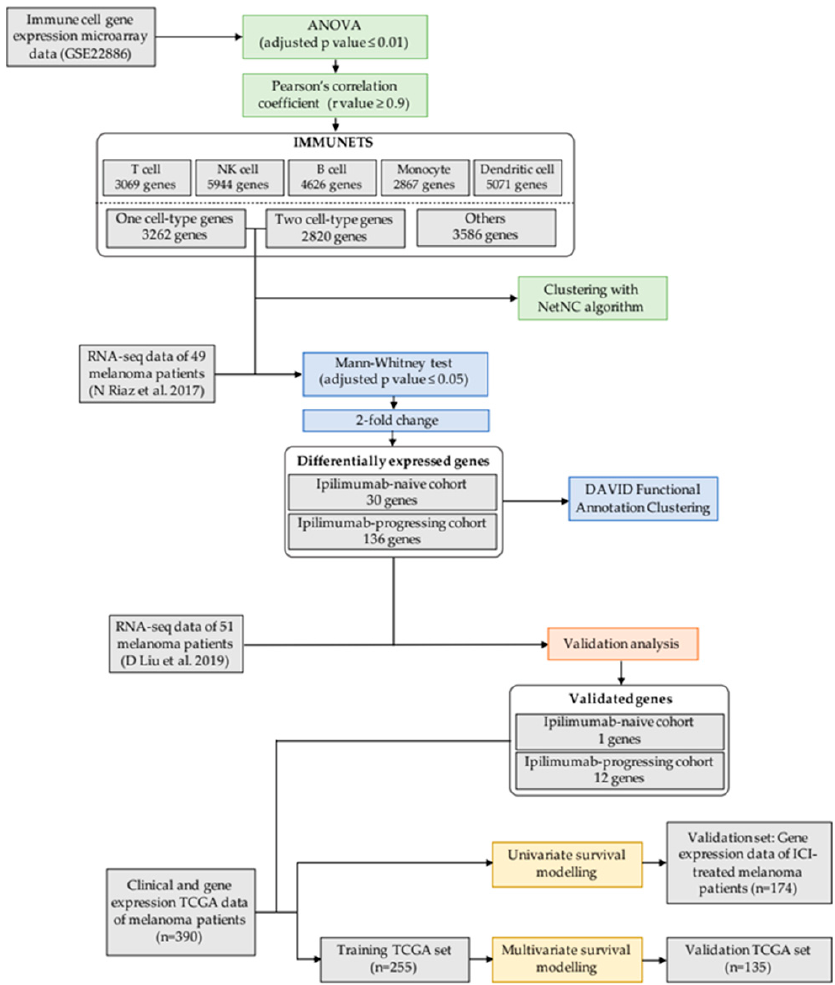
Figure 1. Methodological outline. Networks were constructed from genes that were both highly correlated and differentially expressed across five cell types (IMMUNETS, top). Genes present in at most two of the five IMMUNETS cell networks were input into NetNC, enabling investigation of immune regulation in patients with differing nivolumab response profiles (centre). IMMUNETS genes that correlated with nivolumab response were validated with an independent melanoma dataset ( n = 51); the significant genes (BIO_13) were further investigated in risk stratification (bottom; TCGA_TRAIN, n = 255) taking cohorts independent of prognostic model selection for validation (TCGA_VALID n = 135, MIXED_ICI n = 174).